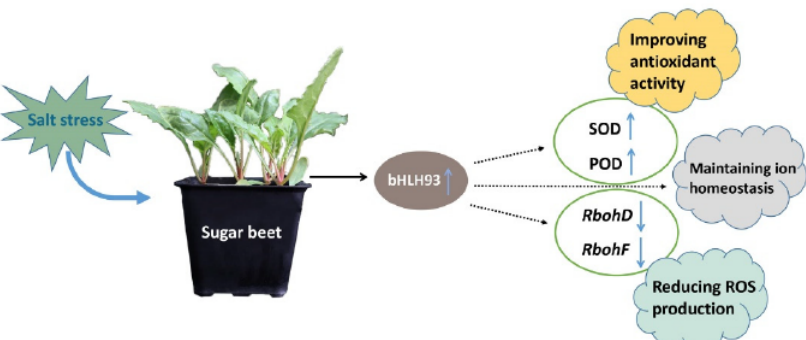
Figure 8. Overview diagram showing how the BvbHLH93 functions in mediating plant salt stress tolerance. Salt stress can turn on the expression of BvbHLH93 , which plays an important role in activating ROS-detoxifying enzymes, leading to reduced ROS levels and maintaining ion homeostasis for plant salt stress